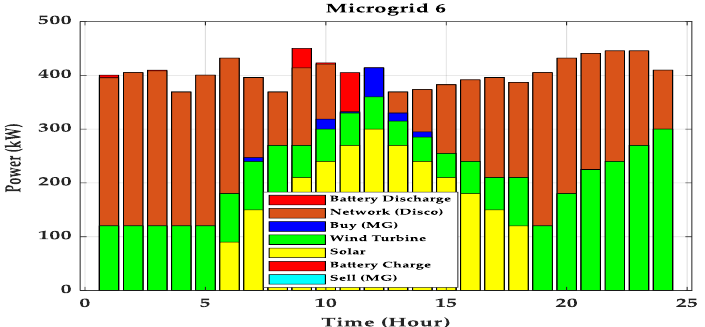
Figure 13. Microgrid 8’s load and generation curve.